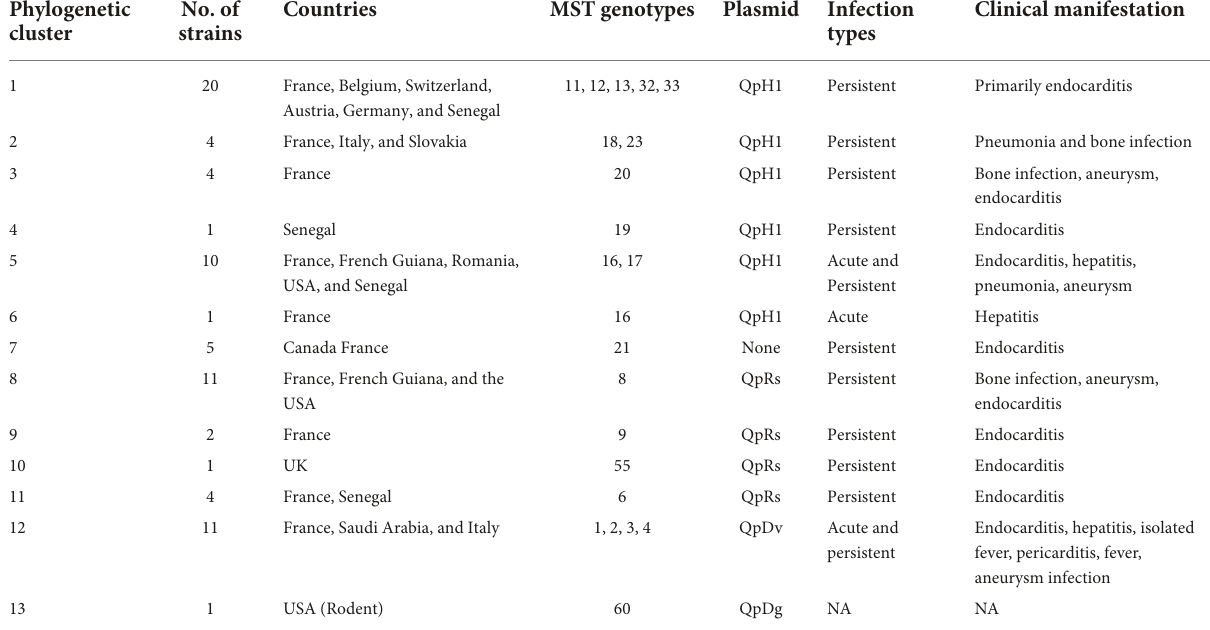
TABLE 2 Summary of phylogenetic analysis of 75 Coxiella genomes. Phylogenetic